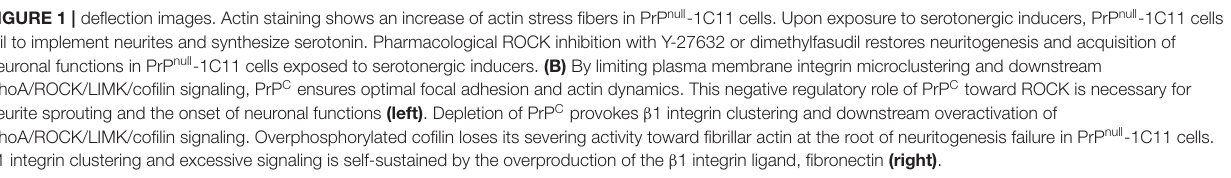
FIGURE 1 | deflection images. Actin staining shows an increase of actin stress fibers in PrP null -1C11 cells. Upon exposure to serotonergic inducers, PrP null -1C11 cells fail to implement neurites and synthesize serotonin. Pharmacological ROCK inhibition with Y-27632 or dimethylfasudil restores neuritogenesis and acquisition of neuronal functions in PrP null -1C11 cells exposed to serotonergic inducers. (B) By limiting plasma membrane integrin microclustering and downstream RhoA/ROCK/LIMK/cofilin signaling, PrP C ensures optimal focal adhesion and actin dynamics. This negative regulatory role of PrP C toward ROCK is necessary for neurite sprouting and the onset of neuronal functions (left) . Depletion of PrP C provokes β 1 integrin clustering and downstream overactivation of RhoA/ROCK/LIMK/cofilin signaling. Overphosphorylated cofilin loses its severing activity toward fibrillar actin at the root of neuritogenesis failure in PrP null -1C11 cells. β 1 integrin clustering and excessive signaling is self-sustained by the overproduction of the β 1 integrin ligand, fibronectin (right)